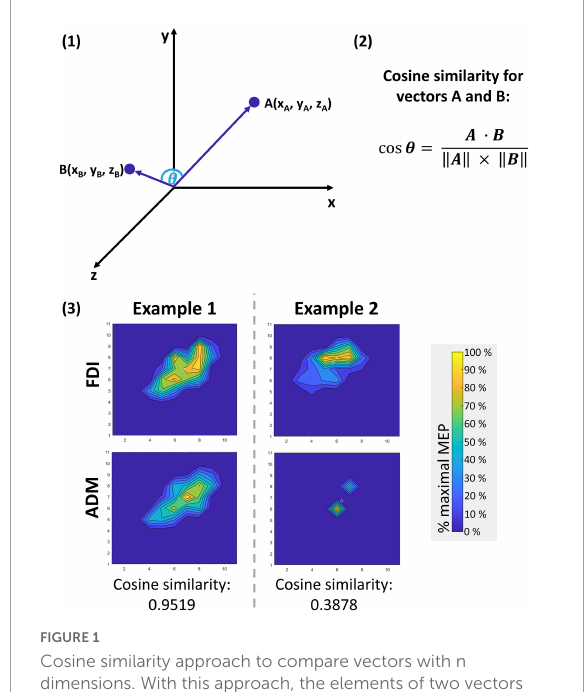
FIGURE1 Cosine similarity approach to compare vectors with n dimensions. With this approach, the elements of two vectors with equal dimensionality n can be compared. In the three-dimensional example given for illustrative purposes in panel (1) below, the vectors A and B each contain three elements ( n = 3) that define their parameter values for the characteristics x, y, and z. Assuming that characteristics x, y, and z can only adopt values ≥ 0 (as given in the present use case), the angle θ between the two vectors can adopt values between 0 ◦ (perfectly similar vectors that might only vary in length) and 90 ◦ (no similarity between the two vectors). By calculating the cosine of 8 using the formula given in panel (2) , the outcome ranges between 0 (no similarity) and 1 (perfect similarity). This approach can likewise be applied to a vector with n = 121 dimensions, as has been done for comparing cortical motor representations for the first dorsal interosseus (FDI) and the abductor digiti minimi (ADM) muscle in this study. In this use case, the dimensionality of the vectors for FDI and ADM each equal the number of the 11 × 11 grid points ( n = 121) and the mean motor evoked potential (MEP) amplitudes of each point are the elements of the vectors for FDI and ADM. Two examples are given in panel (3)